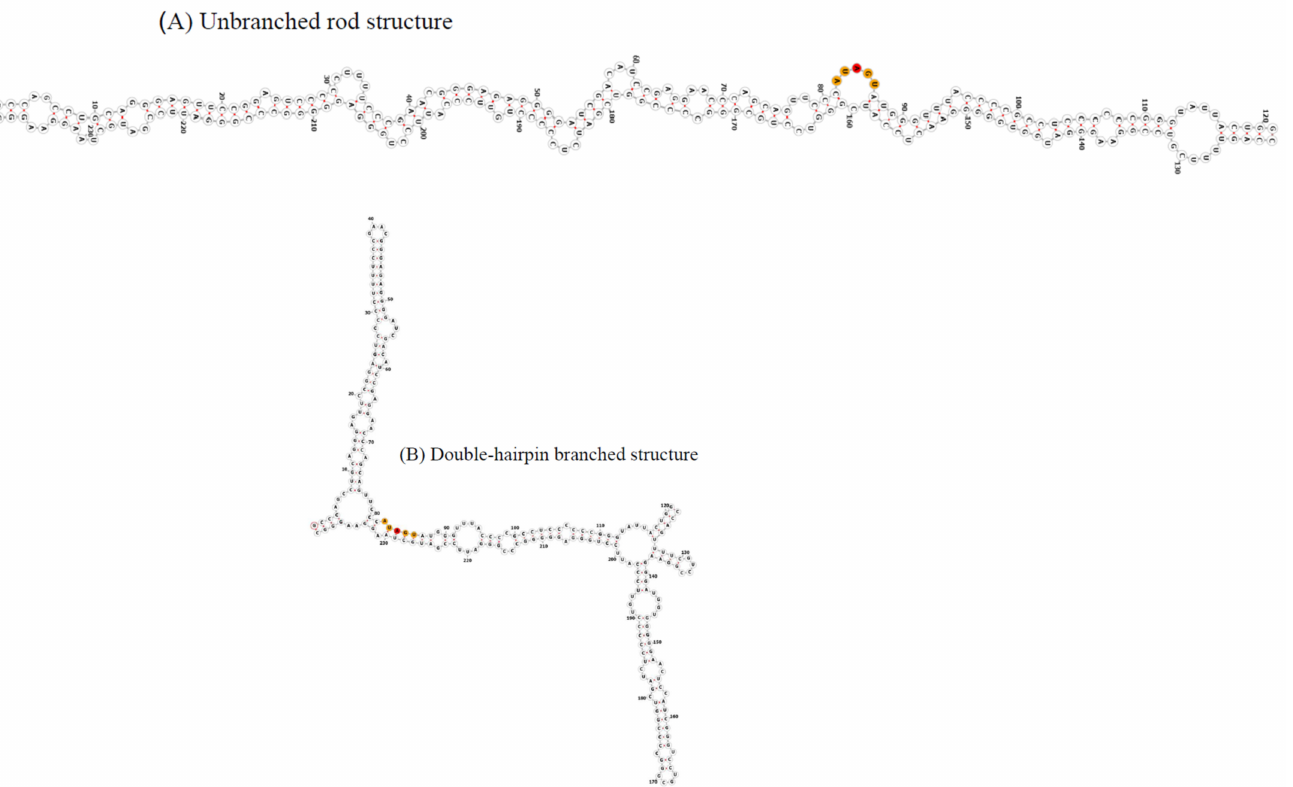
Figure 1. ( A ) To the left, the unbranched rod structure of HDV, isolate Peru-1 (L22063), obtained by mfold prediction with the optimal solution taken, containing the most essential information of Figure 2A of [43]. ( B ) To the right, the double-hairpin branched structure of HDV, isolate Peru-1 (L22063), obtained by mfold prediction with the second suboptimal solution taken, containing the most essential information of Figure 2B of [43]. The five nucleotides “AUAGU” comprising the editing site are